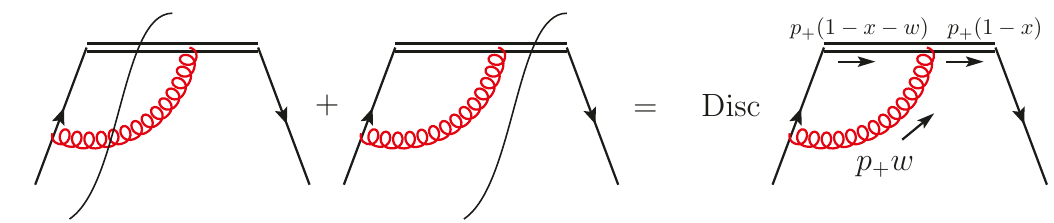
Figure 2. The vertex correction for the one-loop quark PDF. The left-hand side is the standard sum over cuts equating to the discontinuity of the amplitude. The double line is the Wilson line while the solid black line is a